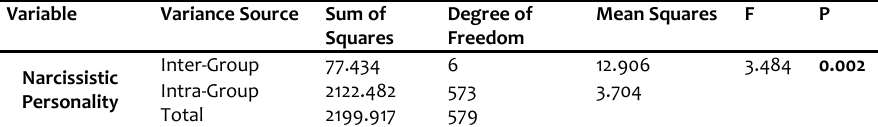
Table 1: Results of the ANOVA of the Narcissistic Personality Scores of the students by Their Faculties Variable Variance Source Sum of